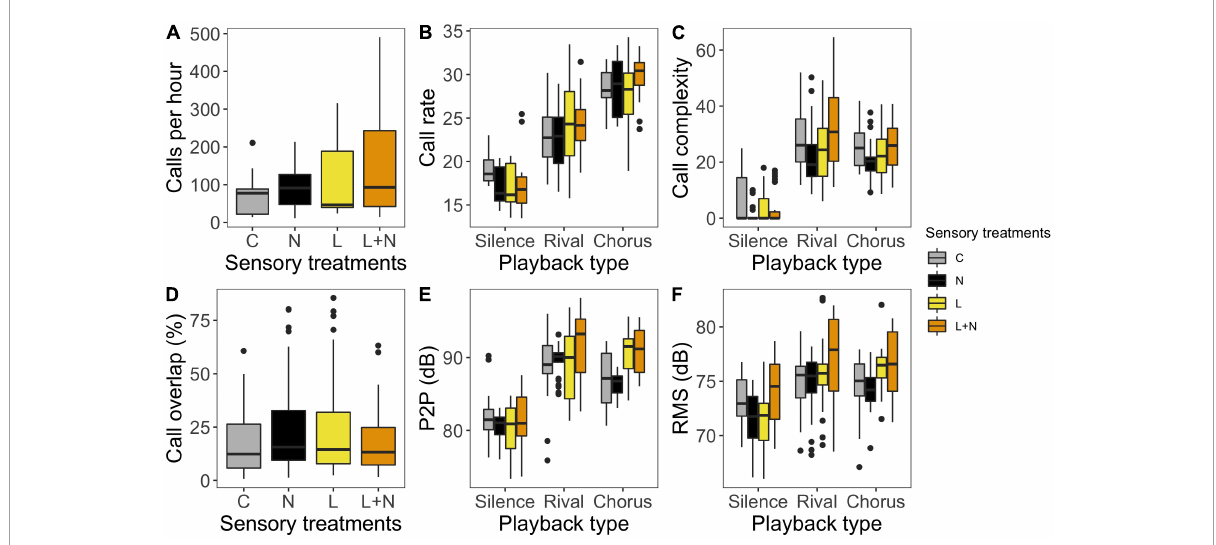
FIGURE3 Calling behavior in response to sensory treatments (Control, Noise, Light, Light + Noise; grey, black, yellow and orange) in different playback types (silence, rival and chorus). (A) Total number of calls per hour. (B) Number of calls per minute. (C) Number of chucks per minute. (D) Percentage of calls overlapping with the played rival call. (E) Peak-to-peak amplitude of whole call. (F) RMS of whole call. Graphs are based on model predictions (excluding the interaction between light and noise in case that was not statistically significant), except for call complexity during silence, which is based on raw data since we ran the model on binary data (chucks/no chucks). See text and Supplementary Tables 2–6 for statistics.